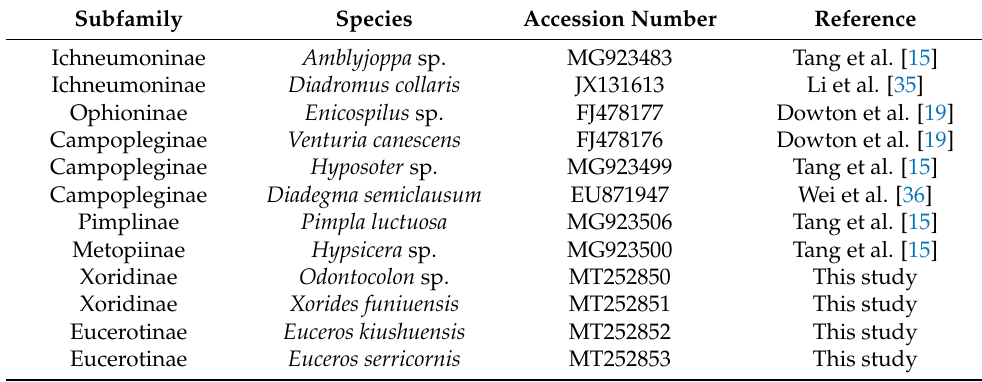
Table 1. Taxonomic information, GenBank accession numbers and references of mitochondrial genomes used in the